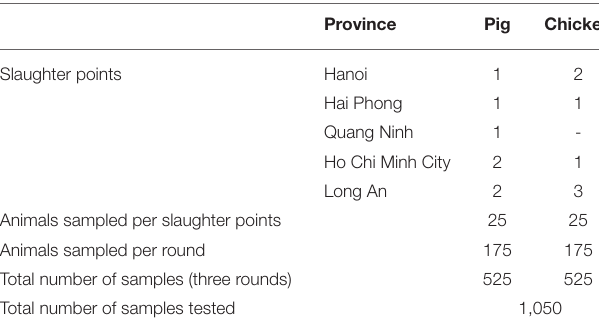
TABLE 1 | Collection of pig and chicken samples during three rounds of antimicrobial resistance surveillance in five provinces in Vietnam, 2017–2019. Province Pig